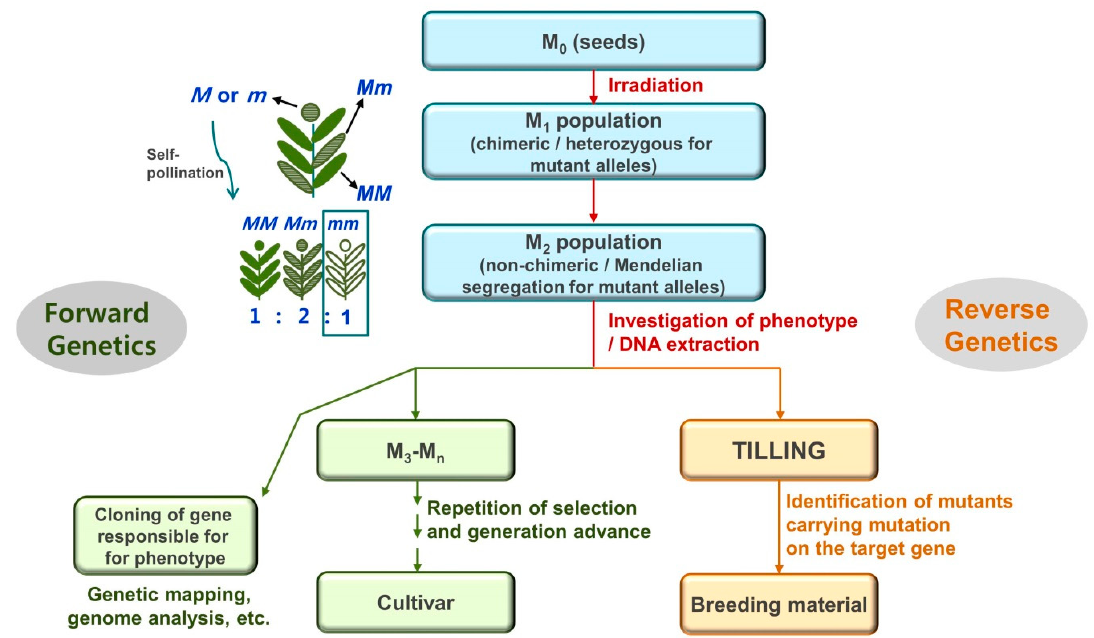
Figure 1. General procedure for the mutation breeding of seed-propagated crops. The M 1 plant is chimeric for each induced mutation because it originates from the irradiated seeds and comprises multiple cells with a diverse mutation spectrum. Selections based on the phenotype or DNA sequences are usually performed with M 2 populations, which do not contain any chimeric individuals. In a forward genetics approach, individuals with a desired phenotype are selected in a population, after which the gene responsible for the phenotype is studied. In reverse genetics approaches, lines with mutated targeted genes are selected, after which the resulting phenotype is investigated.